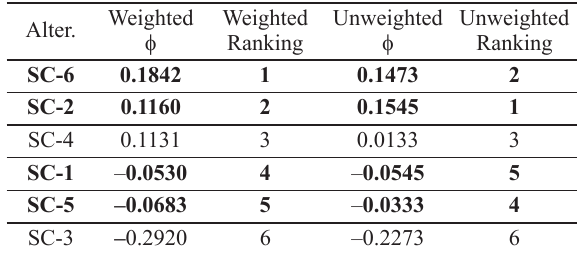
Table 8. Weighted and unweighted rankings